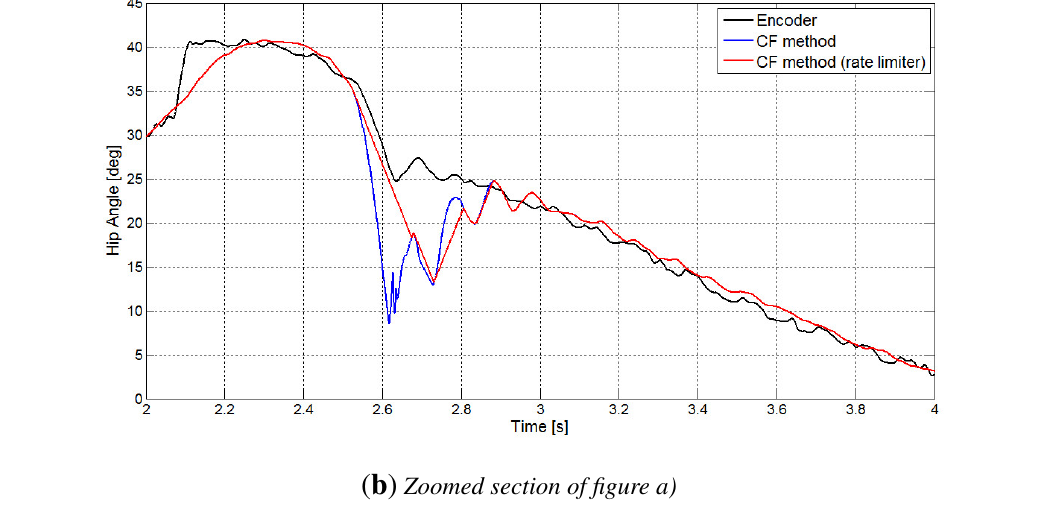
( b ) Zoomed section of figure a)